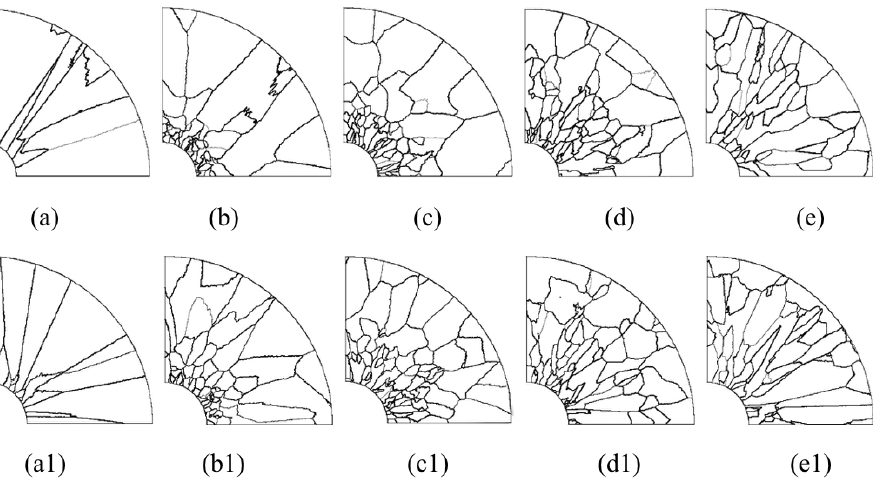
Figure 17. Microstructure morphology predicted of different radial sections with the cooling tem- perature of 25 °C ( a – e : without nickel coating; a1 – e1 : with nickel coating).